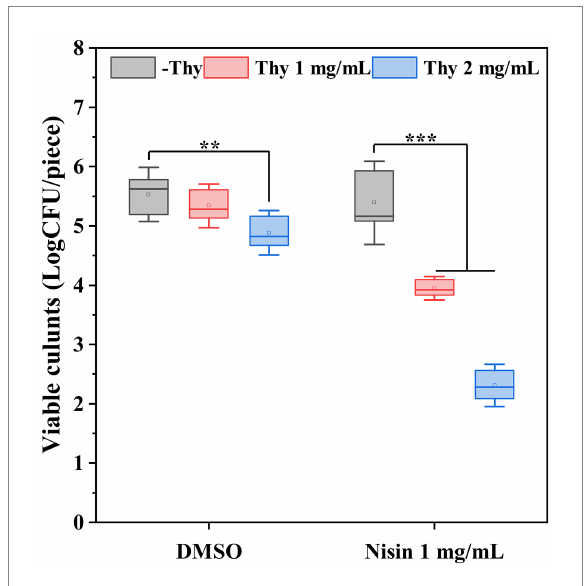
FIGURE 5 Effect of thymoquinone and nisin on biofilm formation of P. aeruginosa PAO1 on lettuce. Statistical differences were determined by ANOVA followed by the Tukey–Kramer test. ( ∗∗∗ ) p < 0.001 versus the DMSO